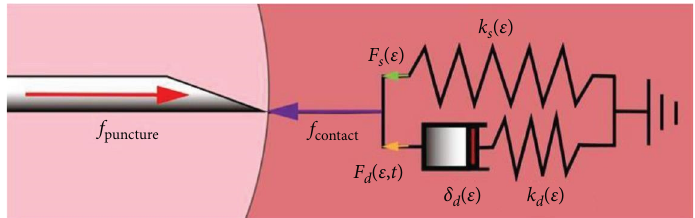
F IGURE 4: Diagram of contact force